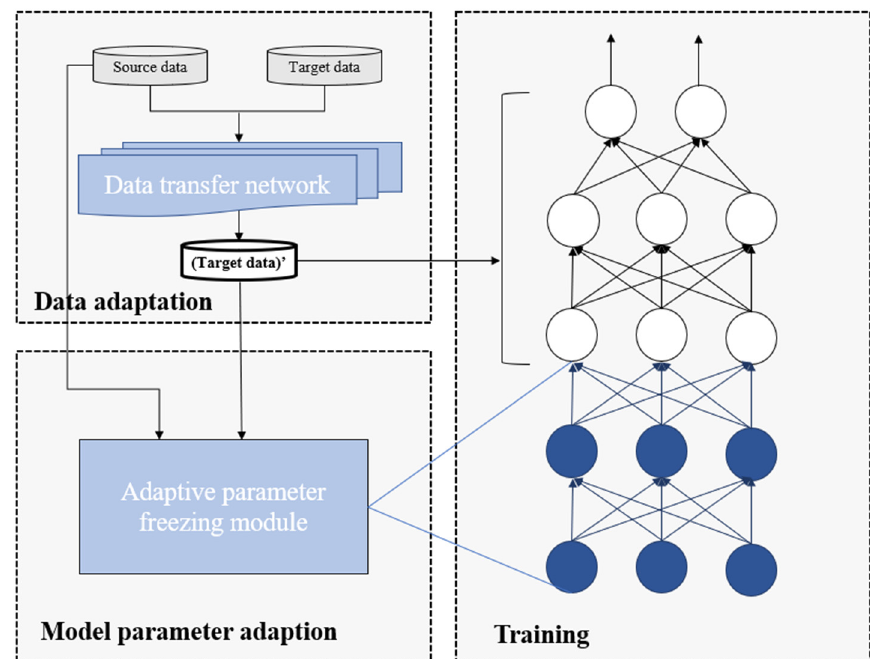
Figure 1. Overall framework of DA-Transfer.